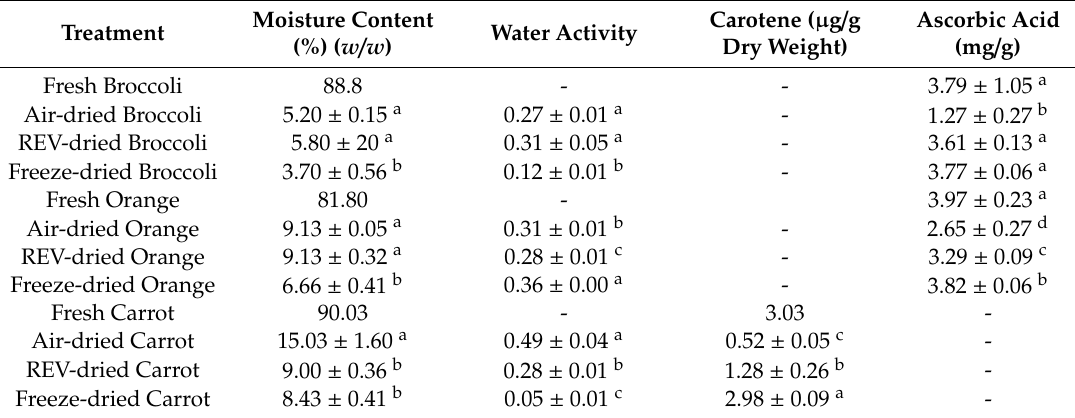
Table 1. Moisture content, water activity, and nutritional value of dried samples with di ff erent drying